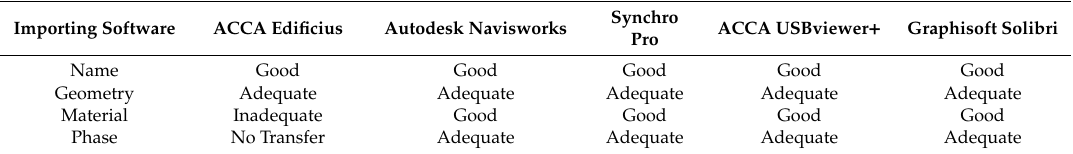
Table 8. Summary of the results of the assessment of BIM software packages tested for interoperability through the IFC standard.